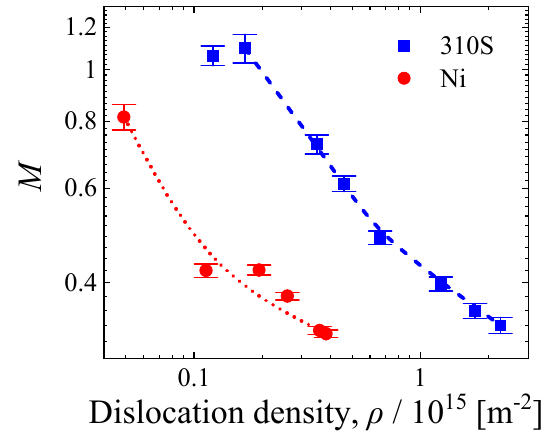
Figure 8. Influence of varying dislocation density on M values.